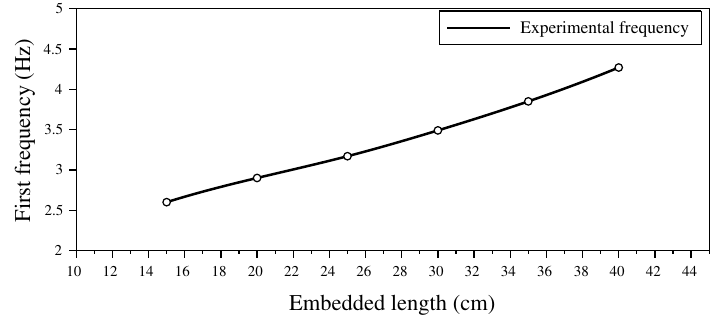
Figure 5. Variation of the first frequency with the embedded length D of the